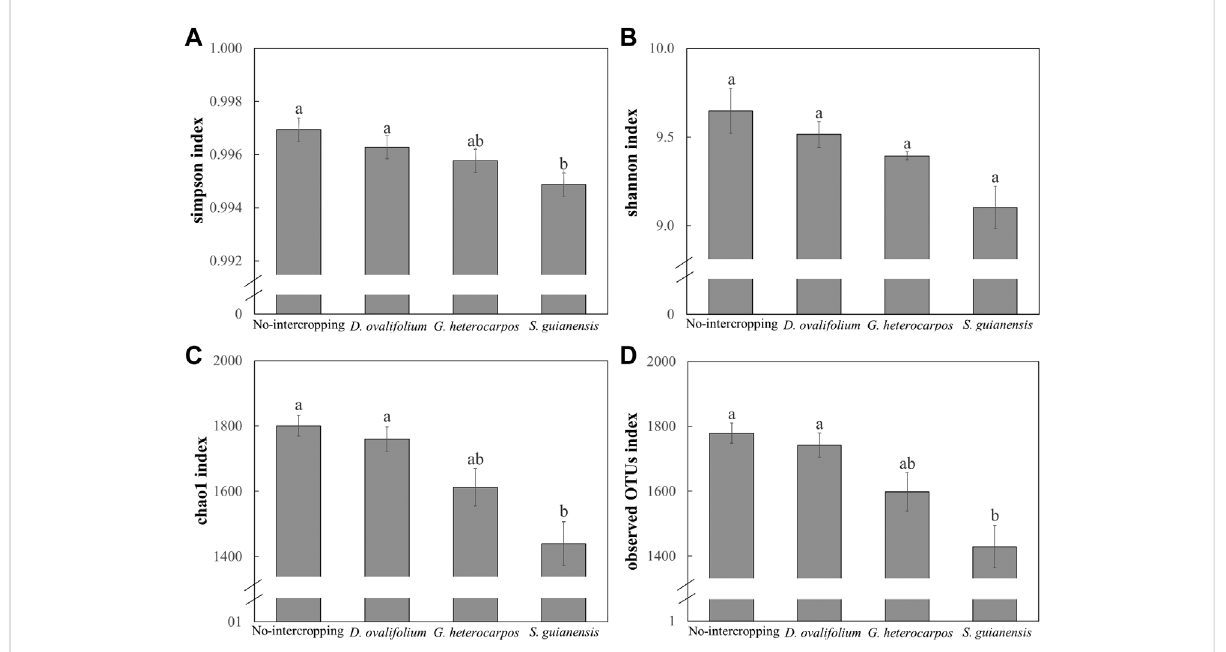
FIGURE 3 Soil bacterial diversity and richness in litchi orchards intercropped with Desmodium ovalifolium , Grona heterocarpos , and Stylosanthes guianensis . Different lowercase letters in the fi gure indicate signi fi cant differences between treatments ( p < 0.05). (A) : Simpson index; (B) : Shannon index; (C) : Chao1 index; (D) : Observed OTUs